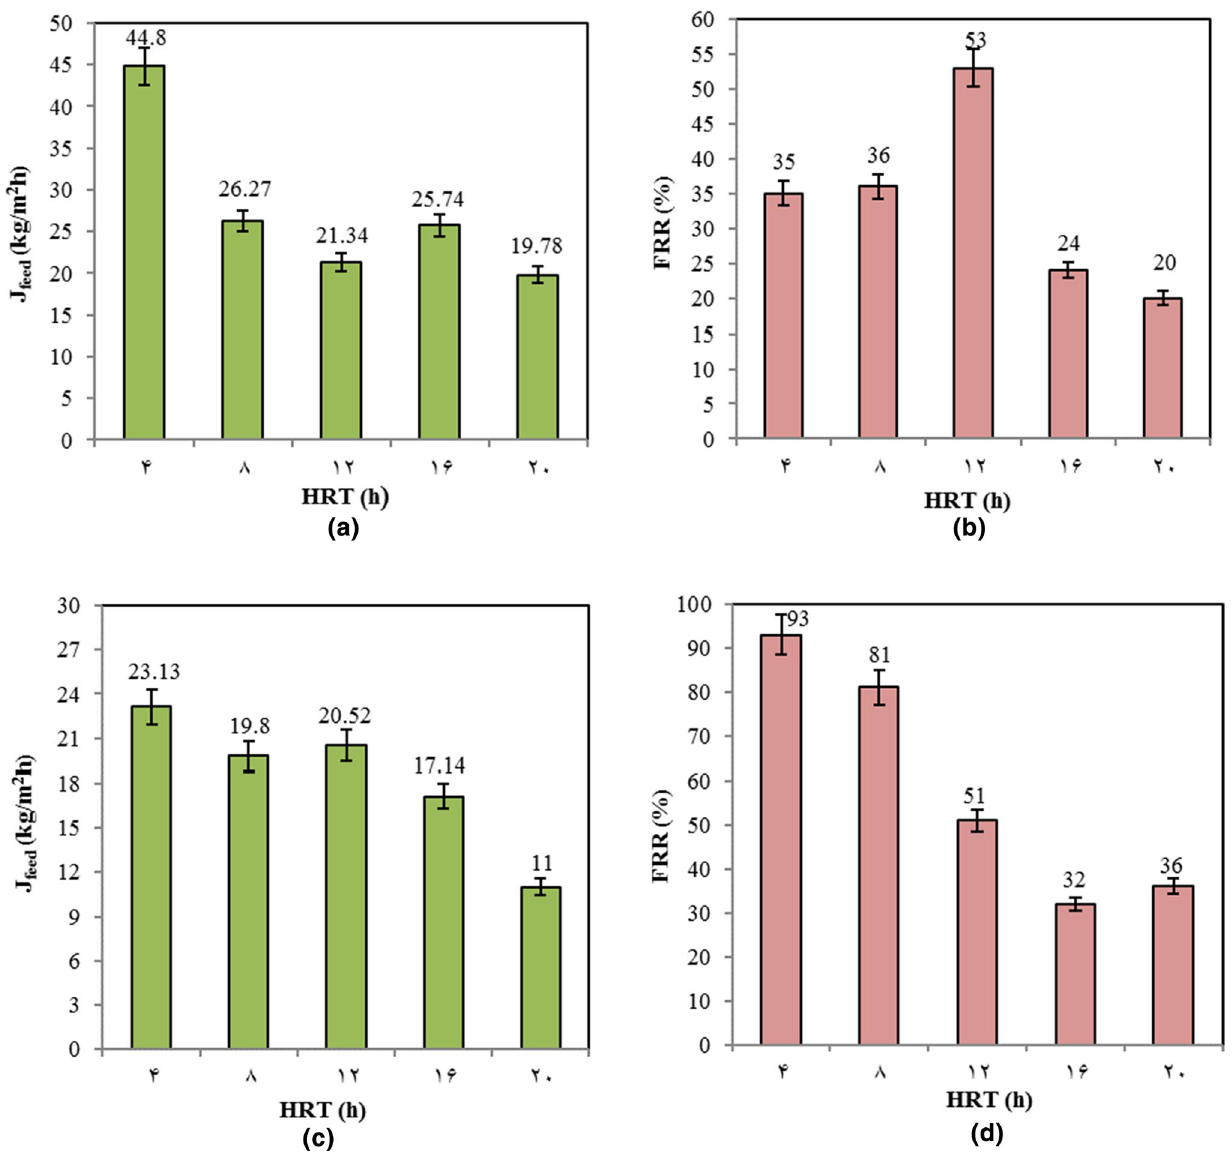
Fig. 2 J feed ( a ) and FRR ( b ) measured for MF membrane at constant pressure of 10 psi and constant pressure of 30 psi at different HRTs for soft drink